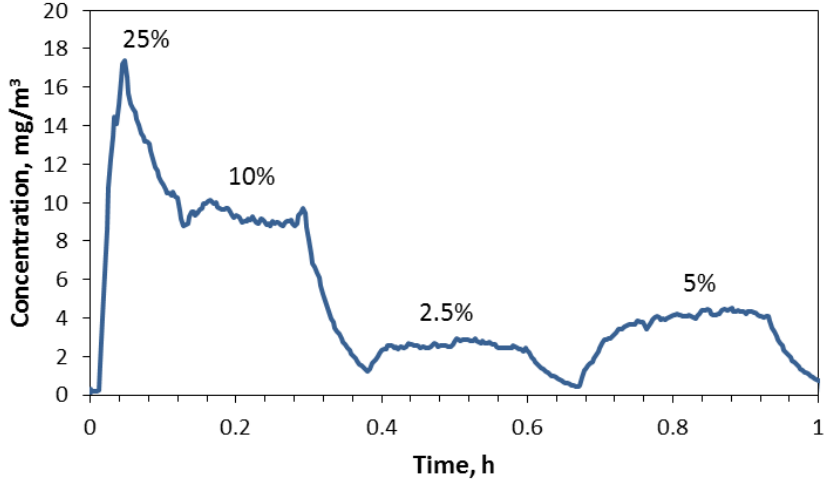
Figure 3. Changes in chamber concentration with step changes in ring speed when using the 0.3 mm